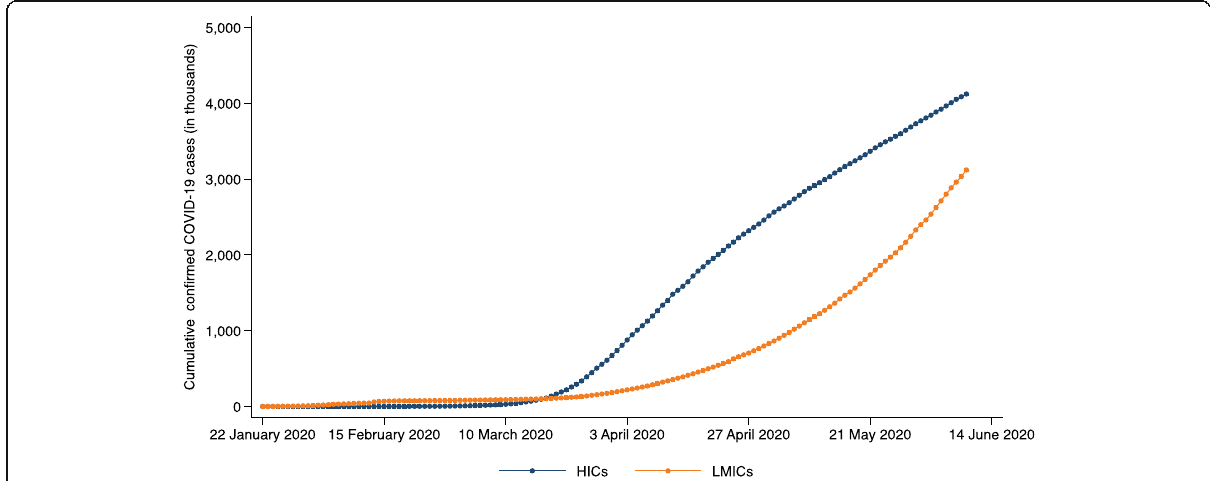
Fig. 1 Cumulative cases of confirmed COVID-19 cases in high-income countries and low- and middle-income countries. HICs = high-income countries; LMICs = low- and middle-income countries. Countries categorized based on World Bank classifications. Cases reported from the Diamond Princess and MS Zaandam cruise ships were considered to have occurred in high-income countries. Data from the Johns Hopkins University Center for Systems Science and Engineering